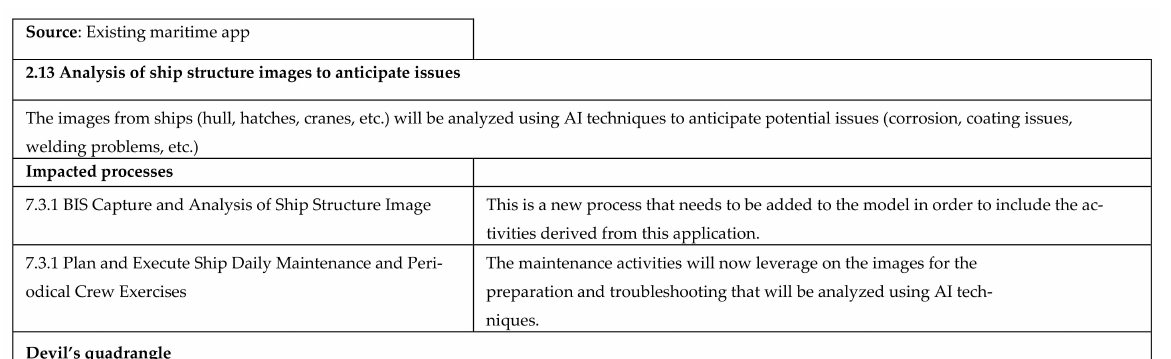
Figure A16. Conversational virtual assistance for helping seafarers in day-to-day activities data sheet.